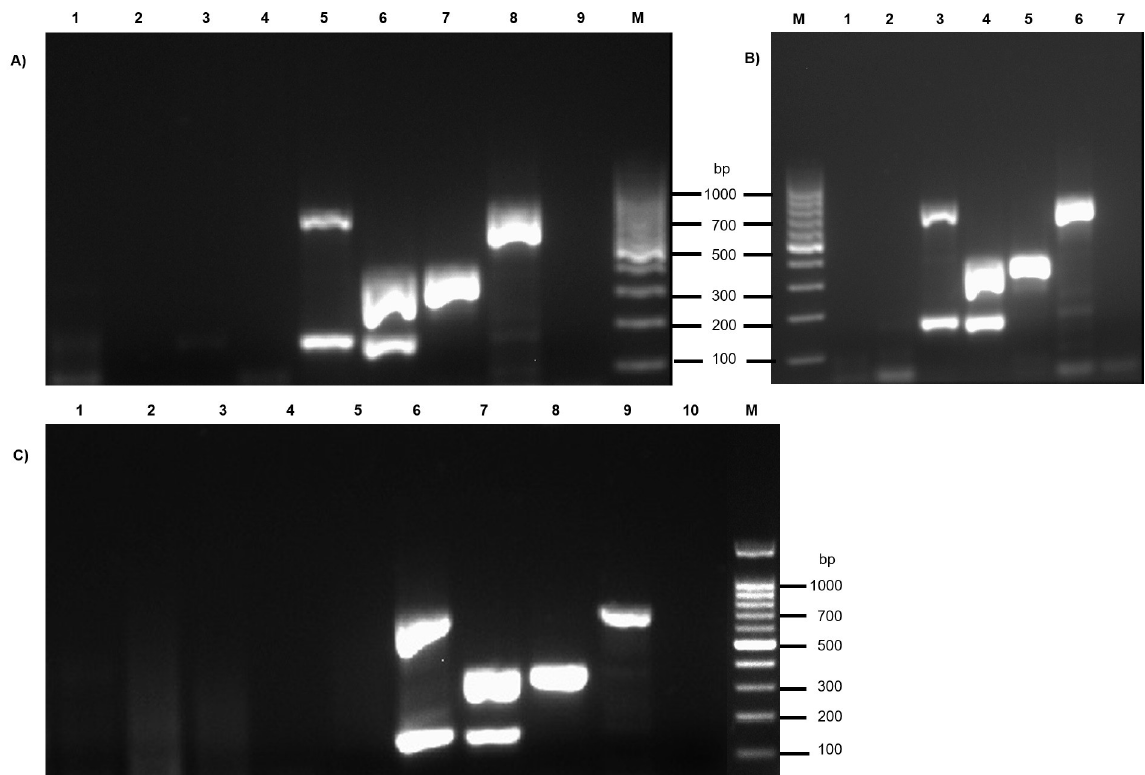
Fig 2. Multiplex RT-PCR specificity test. Agarose gel electrophoresis of PCR products amplified from cell-culture samples and viral and bacterial fish pathogens. A) Lane 1: VHSV; Lane 2: V . harveyi ; Lane 3: V . alginolyticus ; Lane 4: V . gigantis ; Lane 5: RGNNV genotype; Lane 6: RGNNV/SJNNV reassortant strain; Lane 7: SJNNV/RGNNV reassortant strain; Lane 8: SJNNV genotype; Lane 9: No template control; B) Lane 1: BFNNV genotype; Lane 2: TPNNV genotype; Lane 3: RGNNV genotype; Lane 4: RGNNV/SJNNV reassortant strain; Lane 5: SJNNV/ RGNNV reassortant strain; Lane 6: SJNNV genotype; Lane 7: No template control; C) Lane 1: SSN1 cell line; Lane 2: LCDV; Lane 3: V . anguillarum ; Lane 4: P . damselae subsp. piscicida ; Lane 5: A . veronii ; Lane 6: RGNNV genotype; Lane 7: RGNNV/SJNNV reassortant strain; Lane 8: SJNNV/RGNNV reassortant strain; Lane 9: SJNNV genotype; Lane 10: No template control. Lanes M: 100 bp ladder (Invitrogen, Carlsbad,